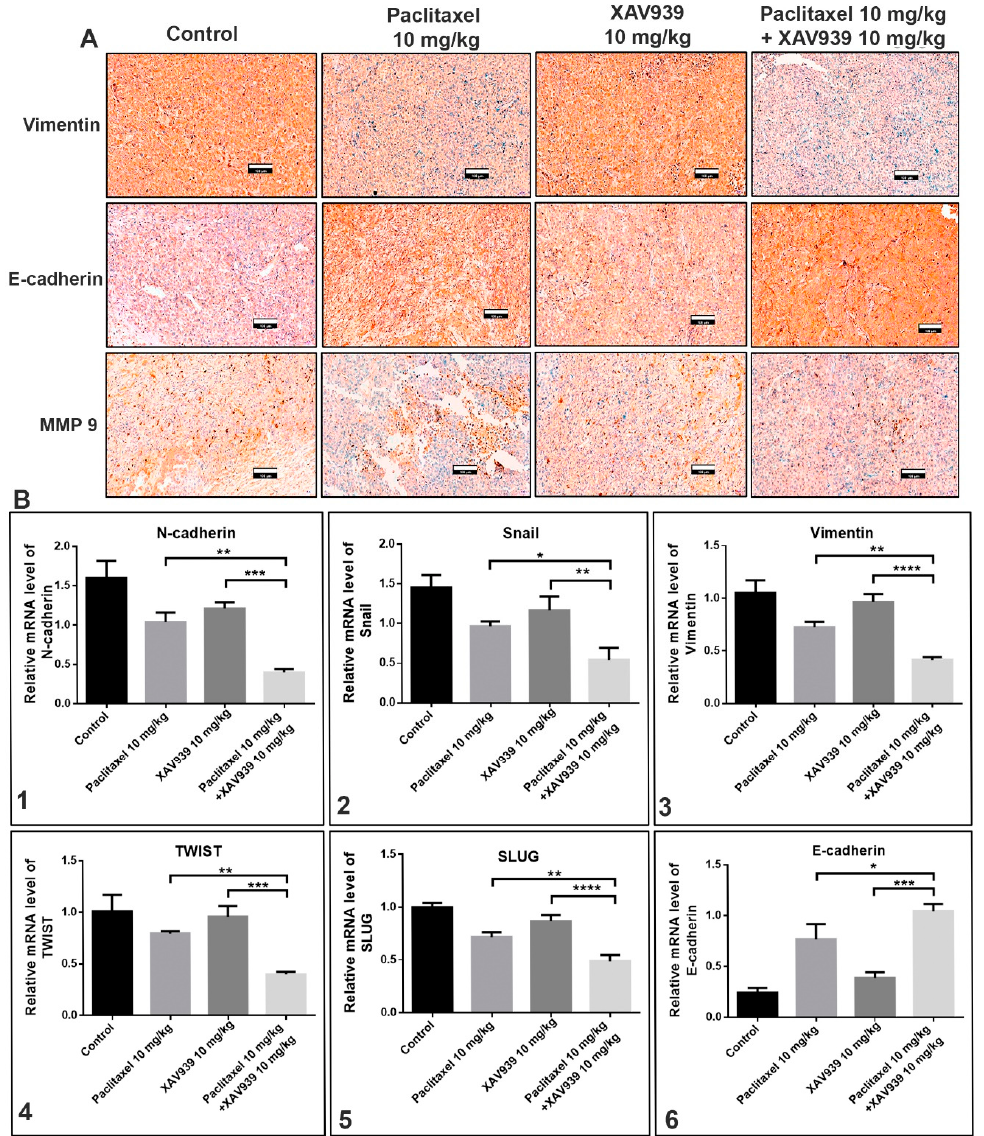
Figure 6. Combination treatment suppressed epithelial-mesenchymal transition ( EMT) regulatory factors at protein and mRNA levels in MDA-MB-231-xenografted breast tumors. ( A ) Tumor sections were subjected to immunohistochemical analysis of vimentin, E-cadherin, and MMP9 using respective antibodies and stained by diaminobenzidine (DAB, dark-brown staining). Photographs were taken at a magnification of 20×. Scale bar = 100 µm. The tumor was lysed, and the mRNA expression levels of ( B-1 ) N-cadherin, ( B-2 ) Snail, ( B-3 ) vimentin, ( B-4 ) TWIST, ( B-5 ) SLUG, and ( B-6 ) E-cadherin were measured by RT-PCR. The relative expression of mRNA was normalized to the reference gene (GAPDH) and presented in a bar graph form. All data are expressed as mean ± SD (n = 3). *: p < 0.05, **: p < 0.005, ***: p < 0.001, and ****: p < 0.0001 when compared to each single treatment with paclitaxel or XAV939. 3.7. Administration of the Combination Regimen of Paclitaxel and XAV939 Suppressed Cell Proliferation and Angiogenesis Markers at Protein and mRNA Levels in MDA-MB-231-Xenografted Tumor Models